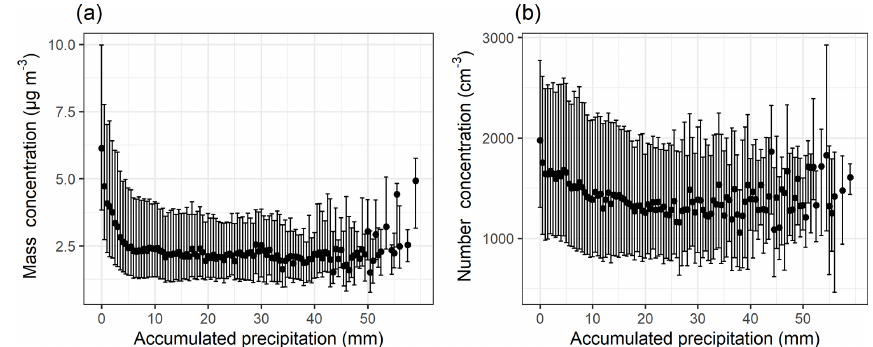
Figure 1. Total particle ( d p = 3–1000nm) mass (a) and number (b) concentration as a function of 0–50mm accumulated precipitation along the 96h HYSPLIT air mass trajectories. The black dots show the median values, and bars highlight the 25th–75th percentiles for each 0.5mm bin of accumulated precipitation. The figure includes DMPS data between January 2005 and August 2019.